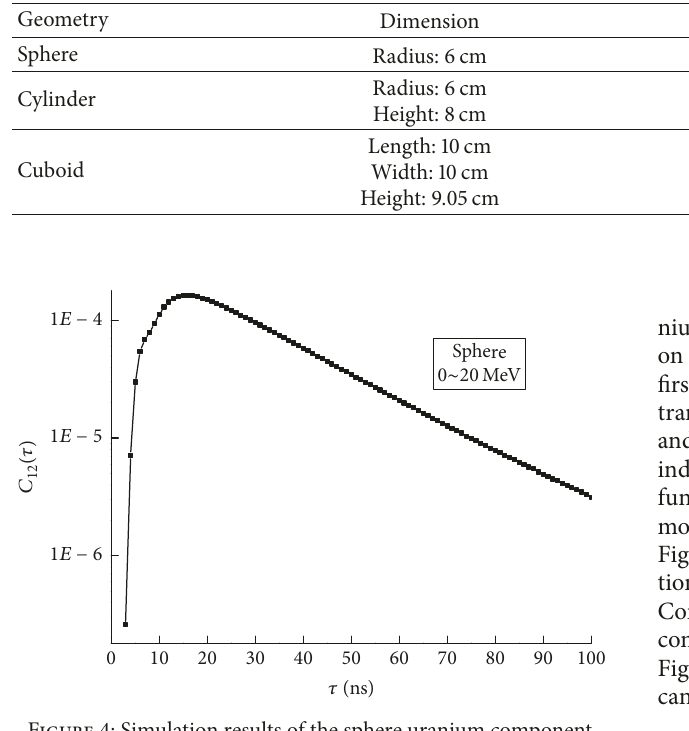
252 Cf spontaneous fission, directly transmitted neutrons, the are detected by the detector, the peaks appeared in the